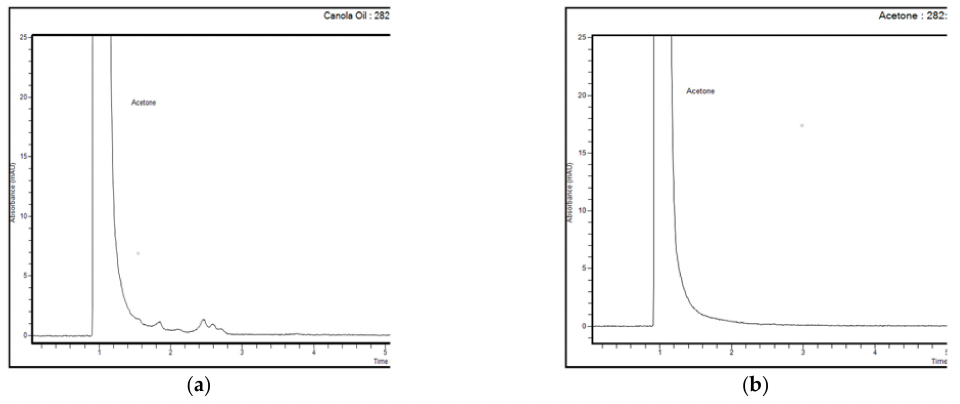
Figure 3. Chromatograms of blank solutions: canola oil 10 mg/mL in acetone ( a ) and acetone ( b